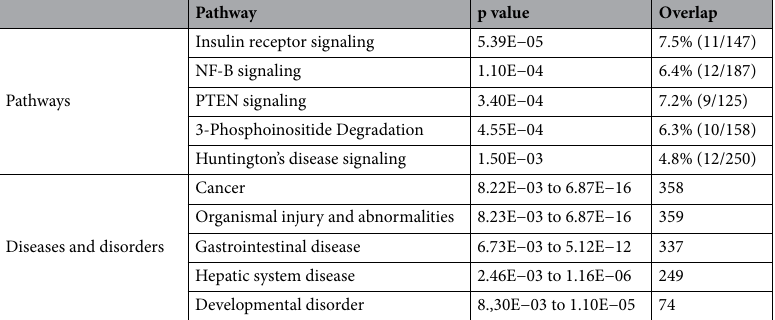
Pathway p value Overlap